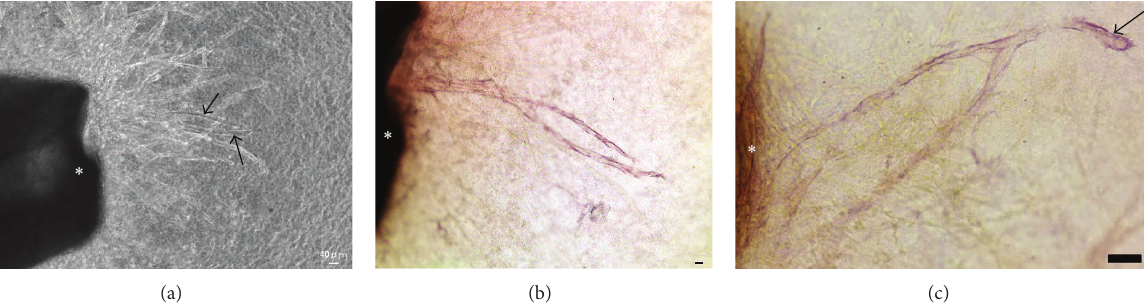
Figure 6: CD133 immunoreactivity in capillary tubes. (a) In the later stages of culture (9-day culture), capillary tubes formed. Phase-contrast microscopy showed that many tubes were formed from the rat aortic explant. Arrows indicate CD133-positive tubes among CD133-negative tubes. Rat aortic explant ( ∗ ). (b) CD133-positive cells were present in a tubular pattern. Photograph showing CD133-positive tubes indicated by arrows in (a). Rat aortic explant ( ∗ ). Scale bar = 20 𝜇 m. (c) CD133 expression was clearly found in the tip region (arrow) of the tube rather than the stalk region near the rat aortic explant ( ∗ ). Scale bar = 20 𝜇 m.